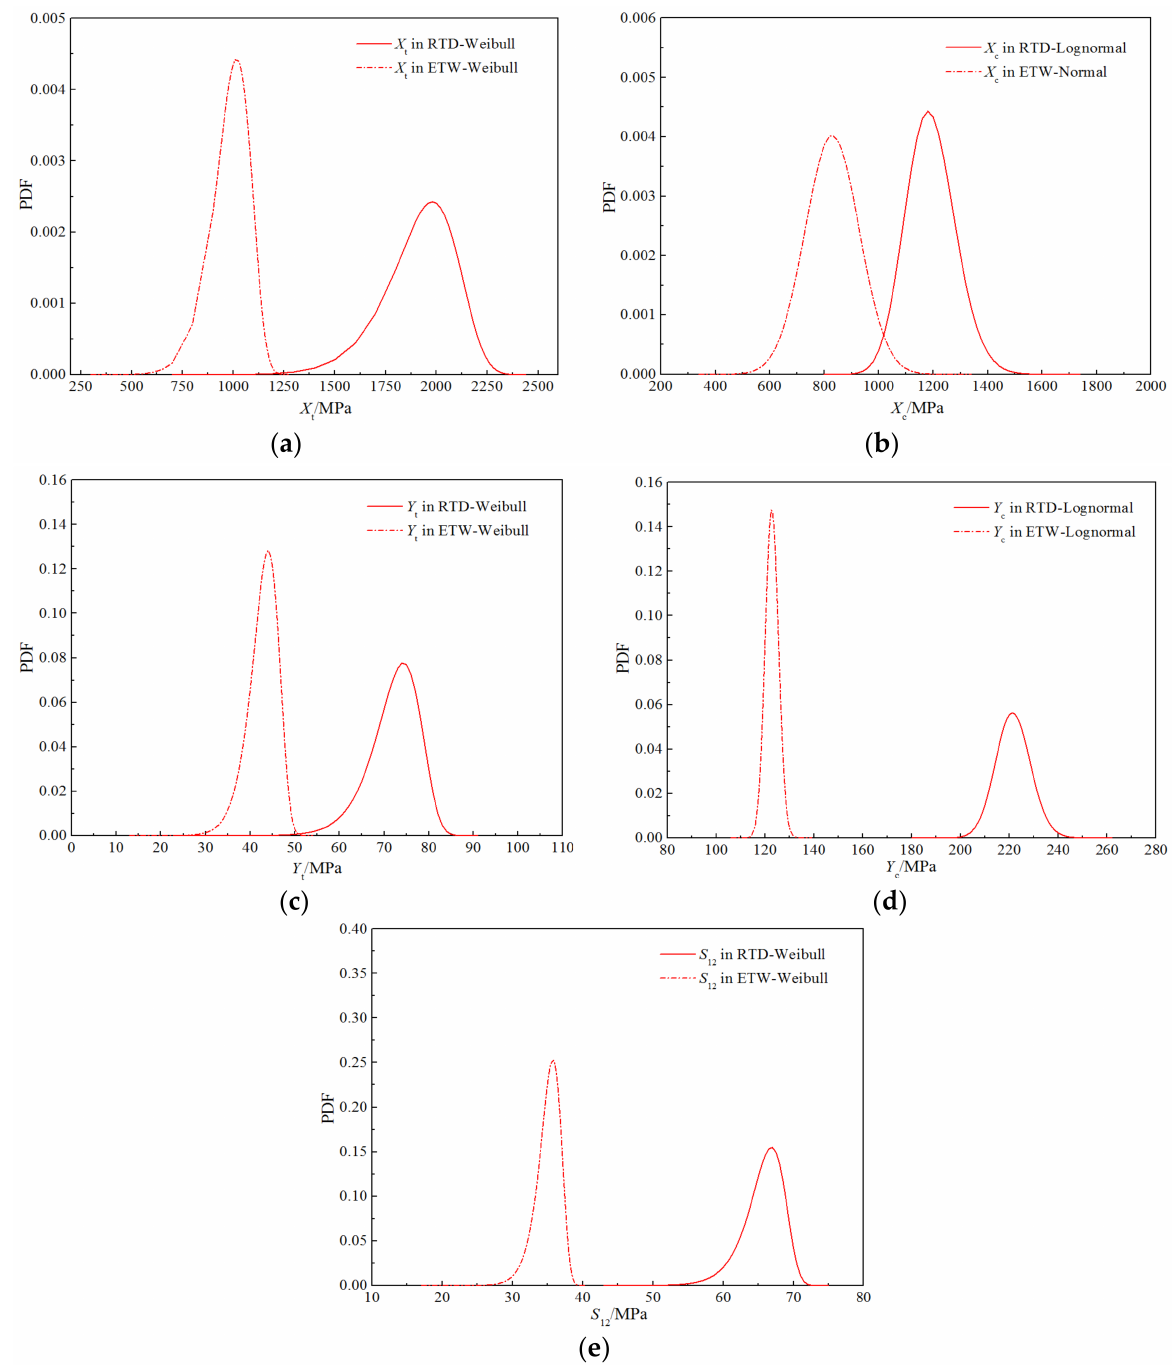
Figure 15. Comparison of the probability curves for the strength properties of H-GFRPs. ( a ) X t , ( b ) X c, ( c ) Y t , ( d ) Y c, ( e ) S 12